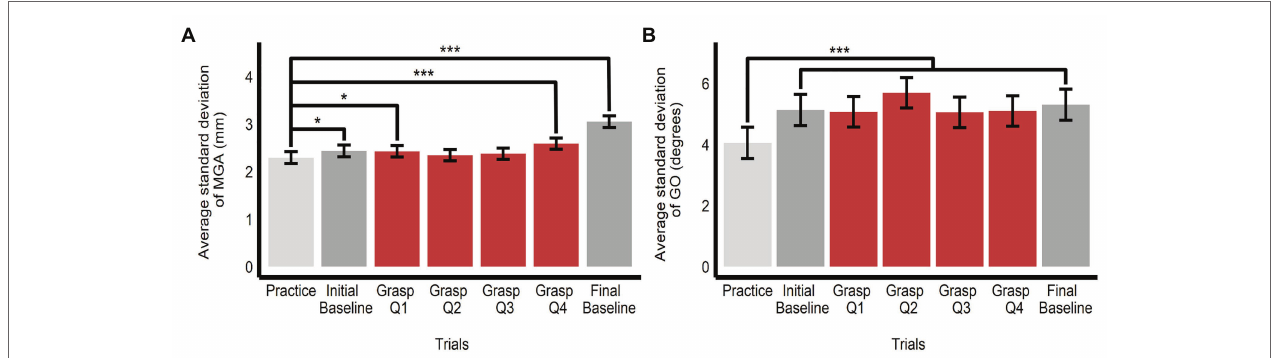
FIGURE 8 | Variability of grasping movements. Estimated marginal means of average SD of (A) maximum grip aperture and (B) grip orientation across the grasping trials (split into one bin of 10 practice trials, one bin of 10 initial baseline trials, four bins of 20 grasping trials each (Q1–Q4), and one bin of 10 final baseline trials). Comparisons are made between practice trials and all other bins. * p < 0.05, *** p < 0.0001; error bars depict SEM; MGA, maximum grip aperture; GO, grip orientation.